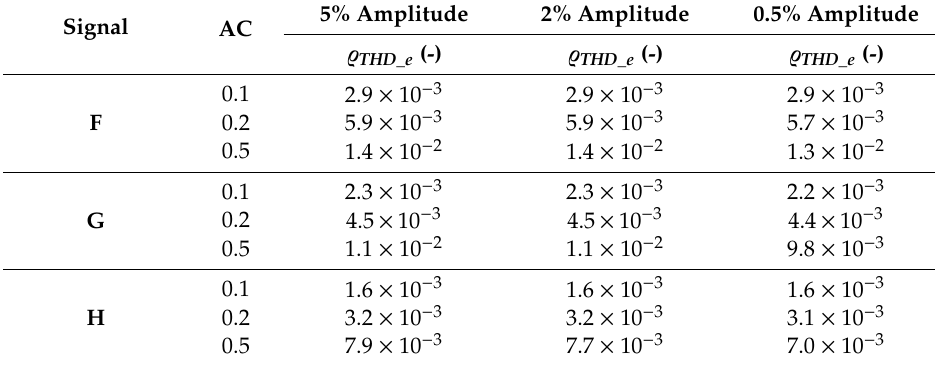
Table 10. Relative standard deviation of the estimated